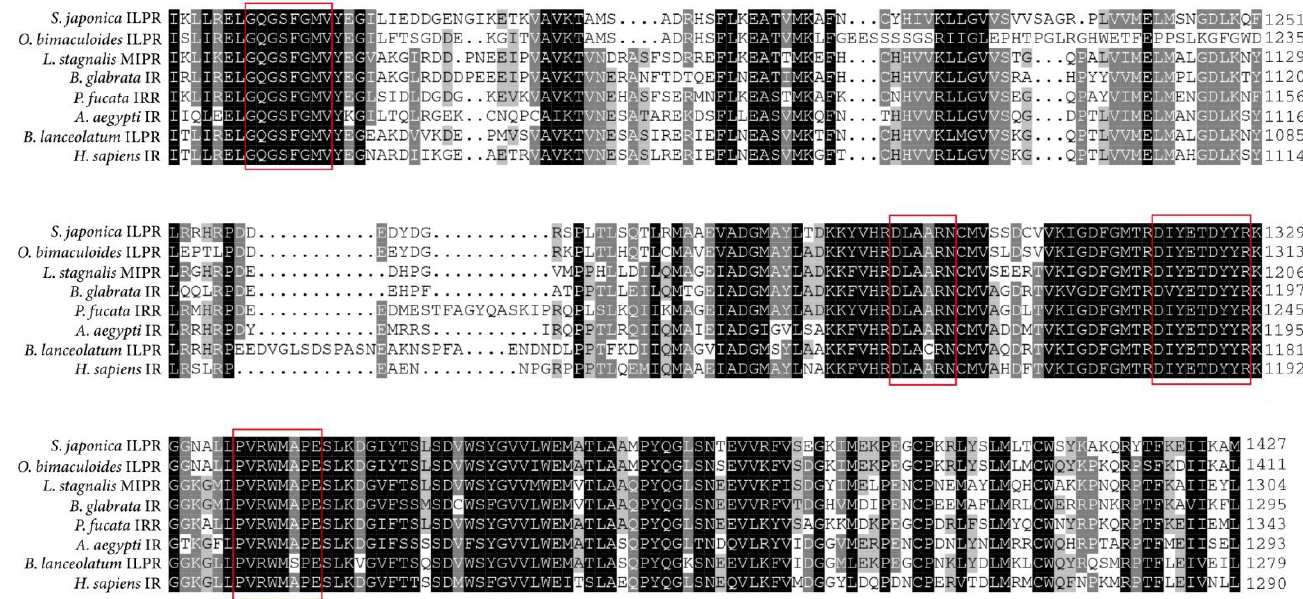
Figure 2. Comparison of the tyrosine kinase catalytic domain of SjILPR with TK domains of IRs from different species. Conserved residues are between the SjILPR and the other seven IRs are shaded in black, grey shading indicates identity with at least one of the seven sequences. Catalytically important residues of the TK domain are red boxed. The accession numbers are shown in Supplementary Table S2.